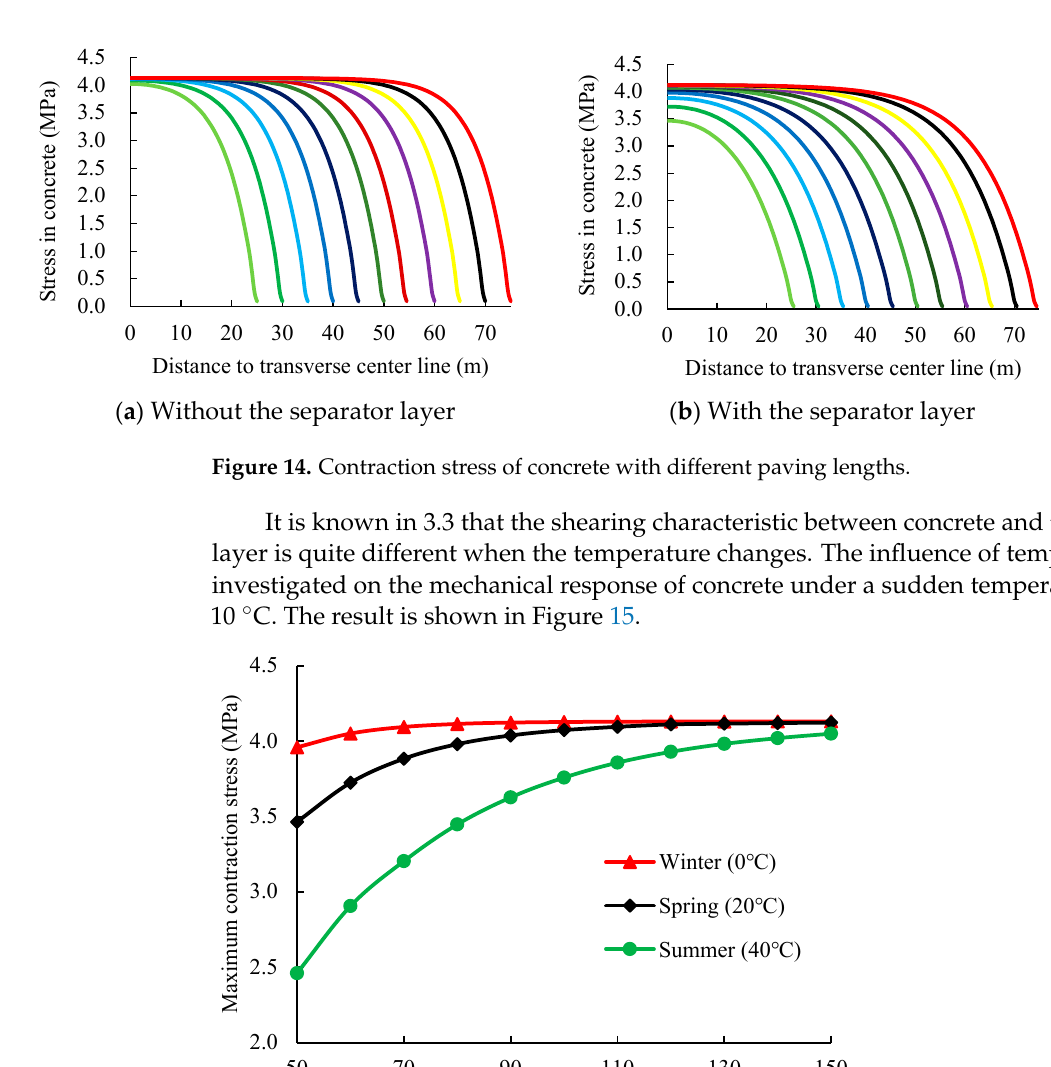
Figure 14. Contraction stress of concrete with different paving lengths.